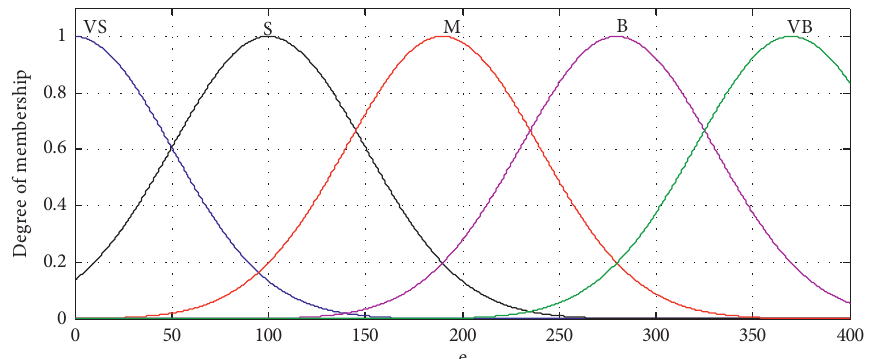
Figure 6: Membership functions for input e .